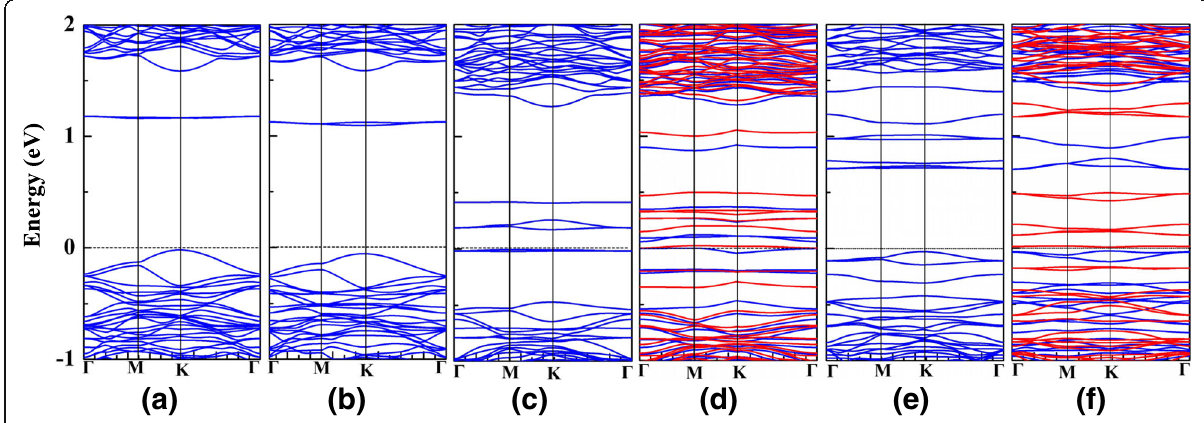
Fig. 3 The electronic band structures of monolayer WSe 2 with a V Se , b V Se-Se , c V W , d V W2 , e V WSe3 , and f V WSe6 vacancies. Blue and red lines represent the majority and minority spin channels, respectively. Fermi level is set as 0